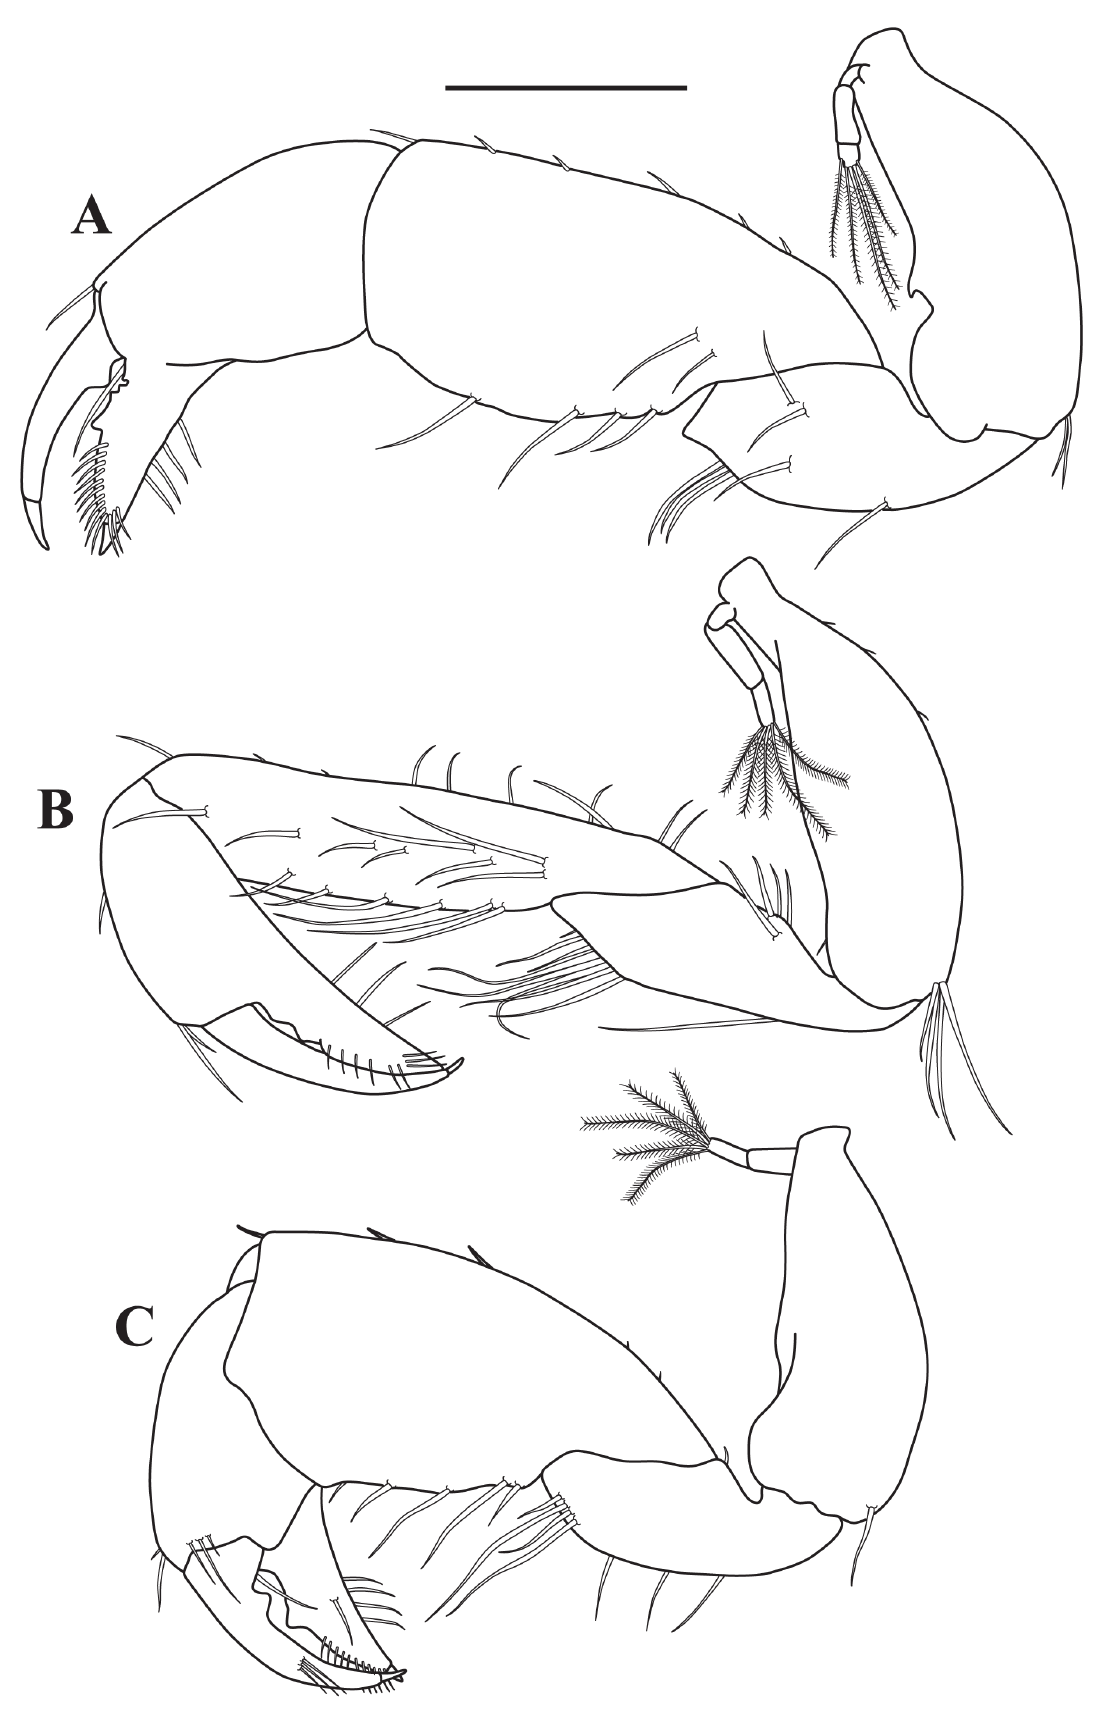
Figure 12. Brachylicoa lui sp. n. paratypes chelipeds: A, male; B, C female. Scale bar = 0.5